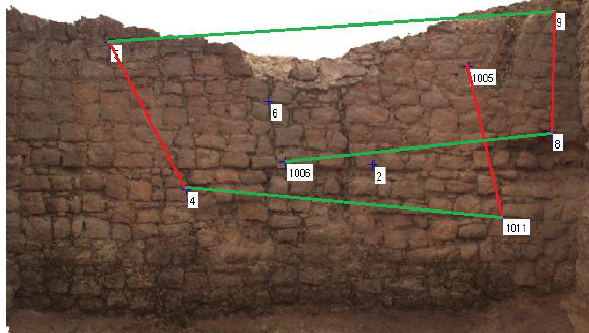
Figure 9. Diagram of the location of the measured control